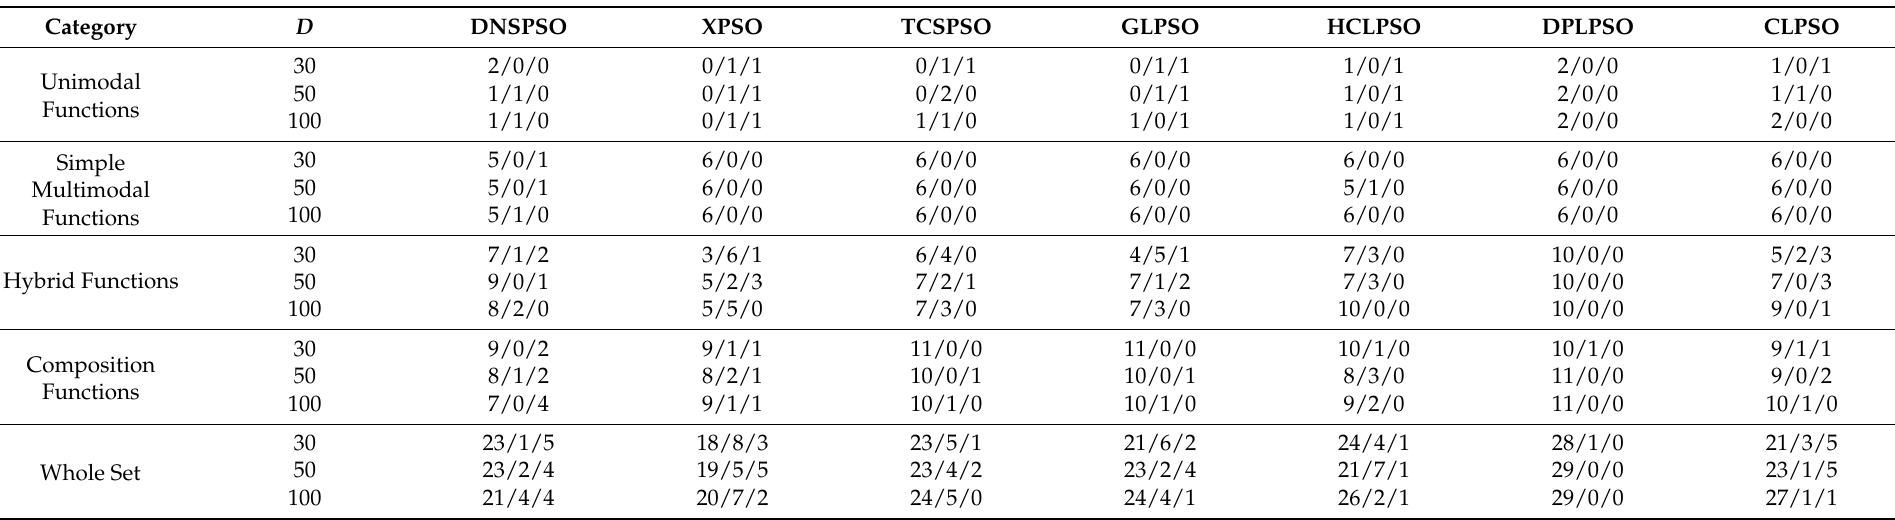
Table 6. Statistical comparison results between the proposed STTPSO and the 7 state-of-the-art and popular PSO variants on the CEC 2017 benchmark set with different dimensions in terms of “ w / t / l